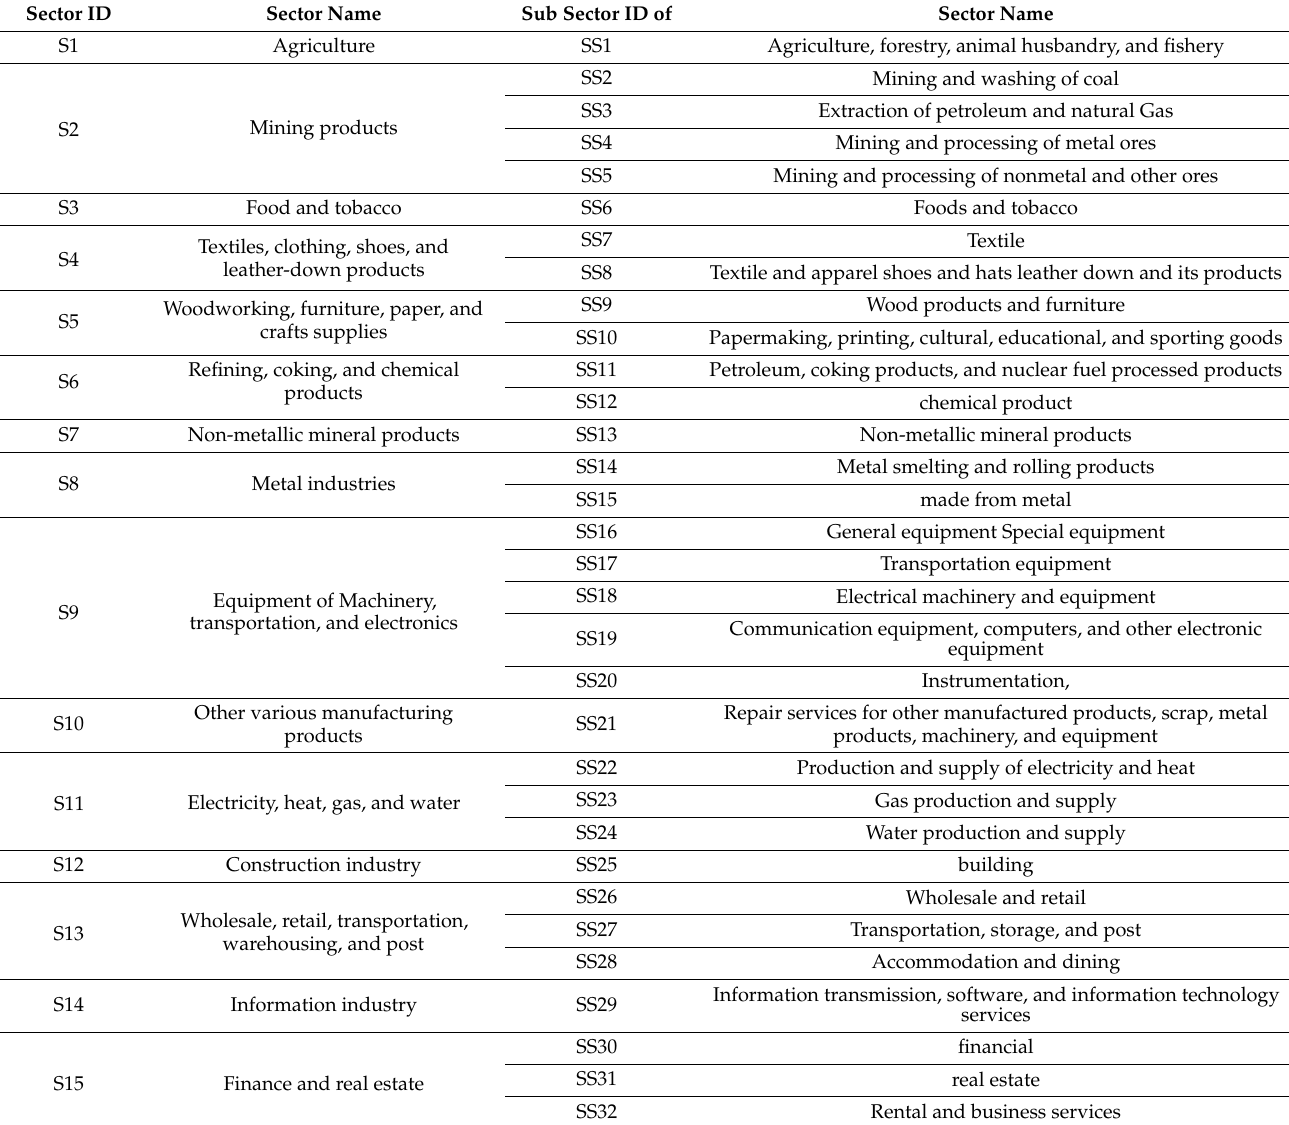
Table A1. 39 Economic sectors and 17 sectors of China for this